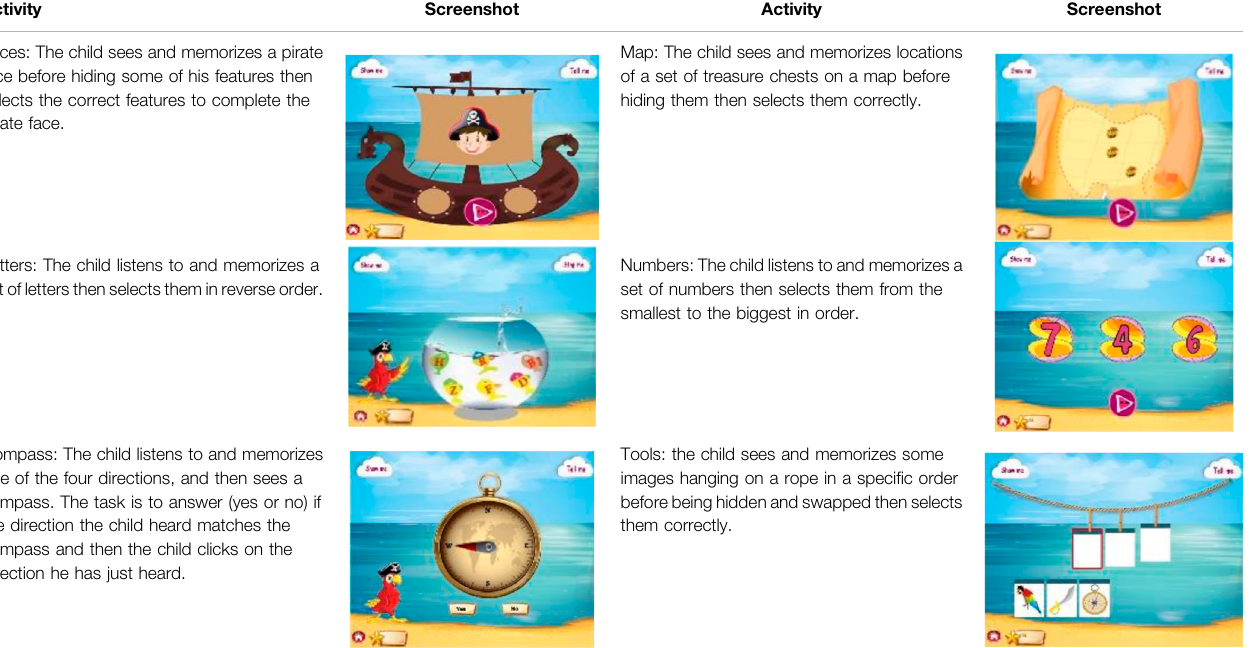
TABLE 1 | Set of screenshots for the six activities of the developed application.